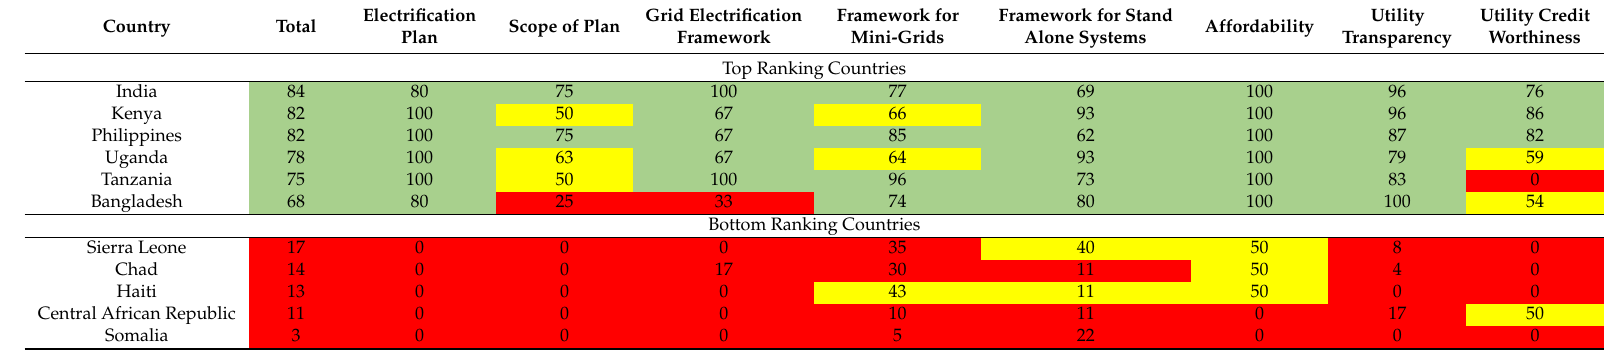
Table 2. Regulatory indicator for energy access in selected